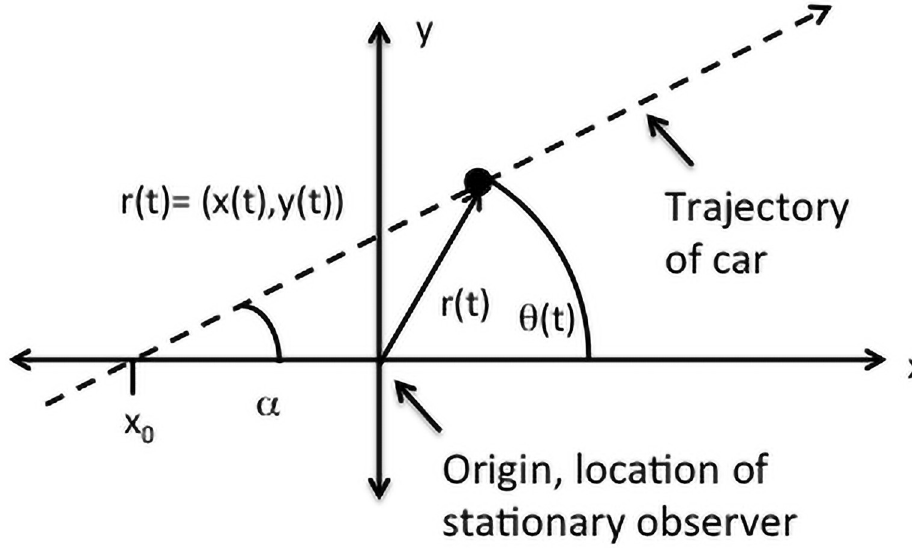
Fig 1. Equation of a line in polar coordinates. Equation of a line in polar